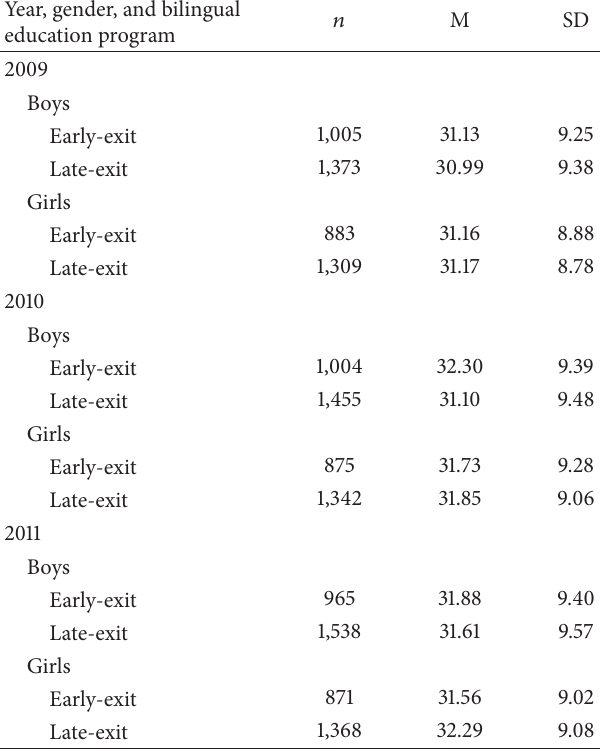
Table 8: Descriptive statistics for the 2009, 2010, and 2011 TAKS MathematicsscoresforGrade6boysandgirlsbybilingualeducation